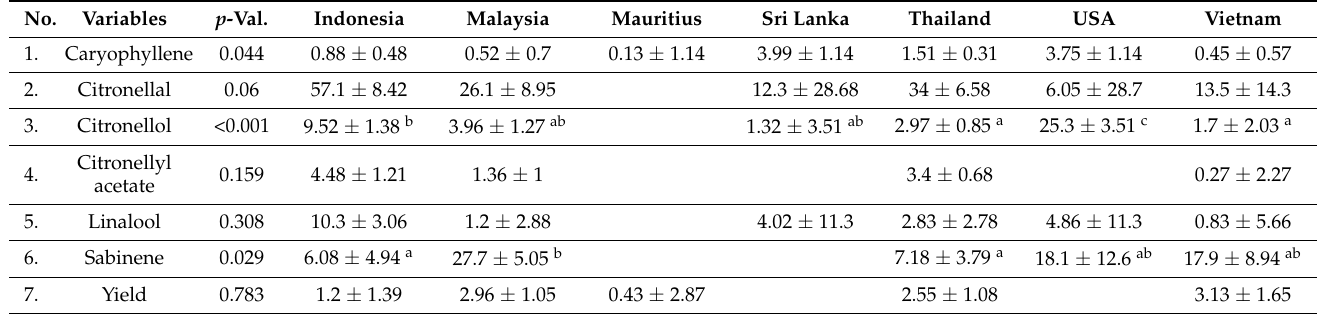
Table 5. Meta-analysis of yield and main components of kaffir lime essential oil in response to plant origin (mean ± standard